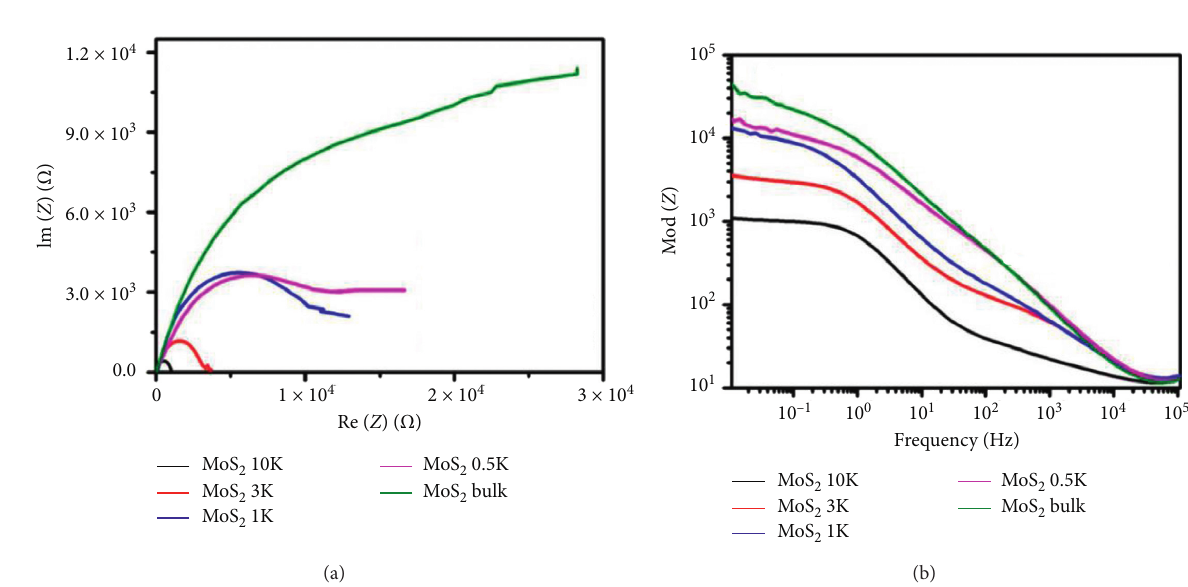
Figure 30: EIS (a) Nyquist and (b) Bode plots of MoS (Figure 29(b)), which is a plot of a pair of graphs recording log | Z | and θ against log f [161, 162].